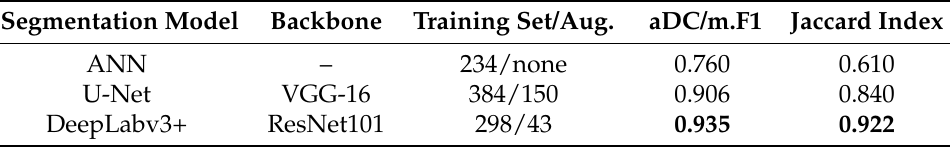
Table 6. Summary of evaluation of spike segmentation models. The aDC score characterizes over- lap between predicted plant/background labels and the binary ground truth labels as defined in Section 2.6. The U-Net and DeepLabv3+ training sets include 150 and 43 augmented images on a baseline data set of 234 images in total. Therefore, no augmentation was used by the training of ANN. The best results are shown in